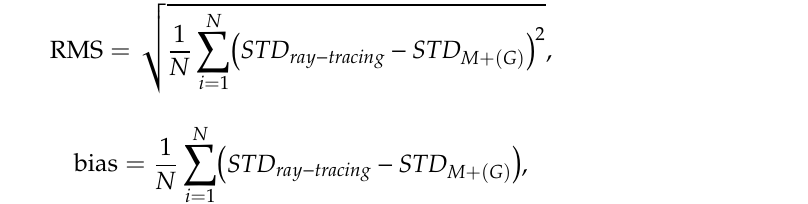
Table 2. The mean value, annual amplitude, and semi-annual amplitude of precipitable water vapor (PWV) in the six regions.